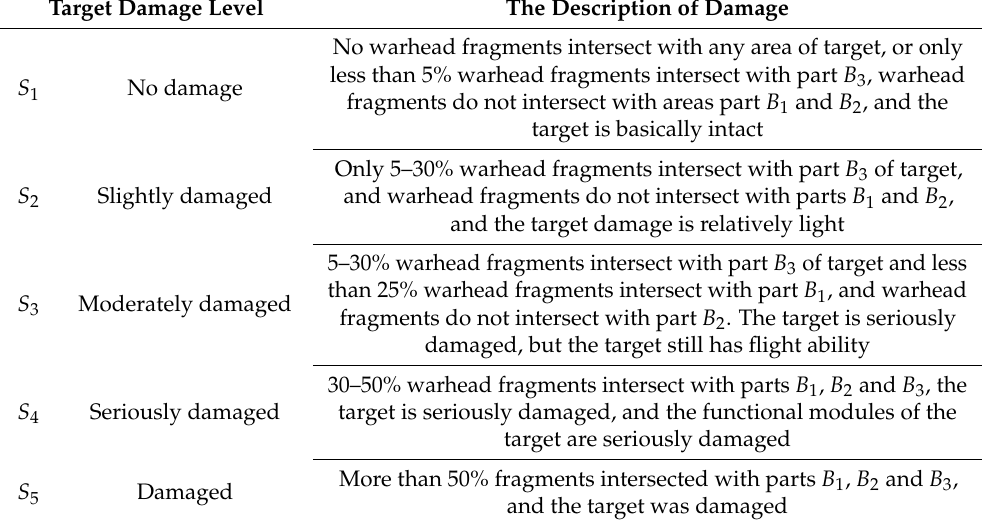
Table 1. The description of target damage level.